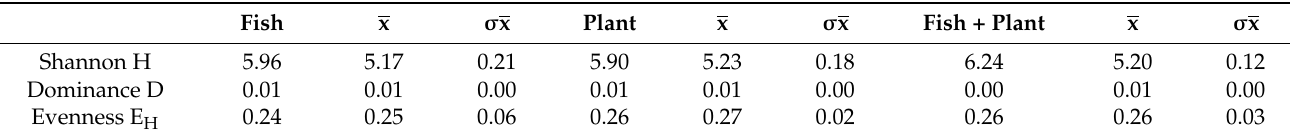
Table 3. Shannon diversity index (H), Dominance (D), and Evenness (EH) of total prokaryotic operational taxonomic units (zOTUs) for three independent demonstrative aquaponics systems. Samples were grouped by fish ( n = 3), plant ( n = 3), and fish + plant compartments ( n = 6) followed by average (x) and standard error ( σ x). Analysis was performed using PAST4